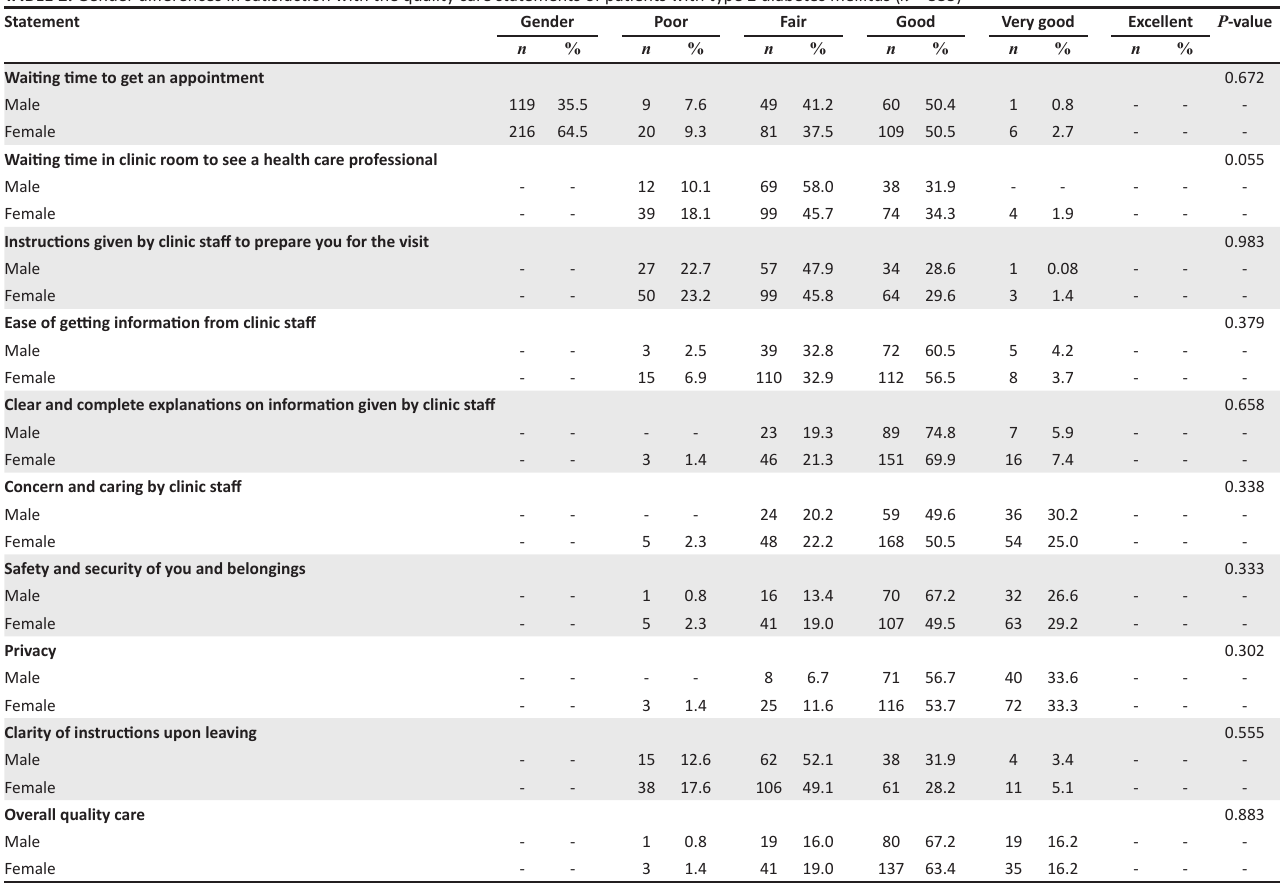
TABLE 2: Gender differences in satisfaction with the quality care statements of patients with type 2 diabetes mellitus ( n = 335)